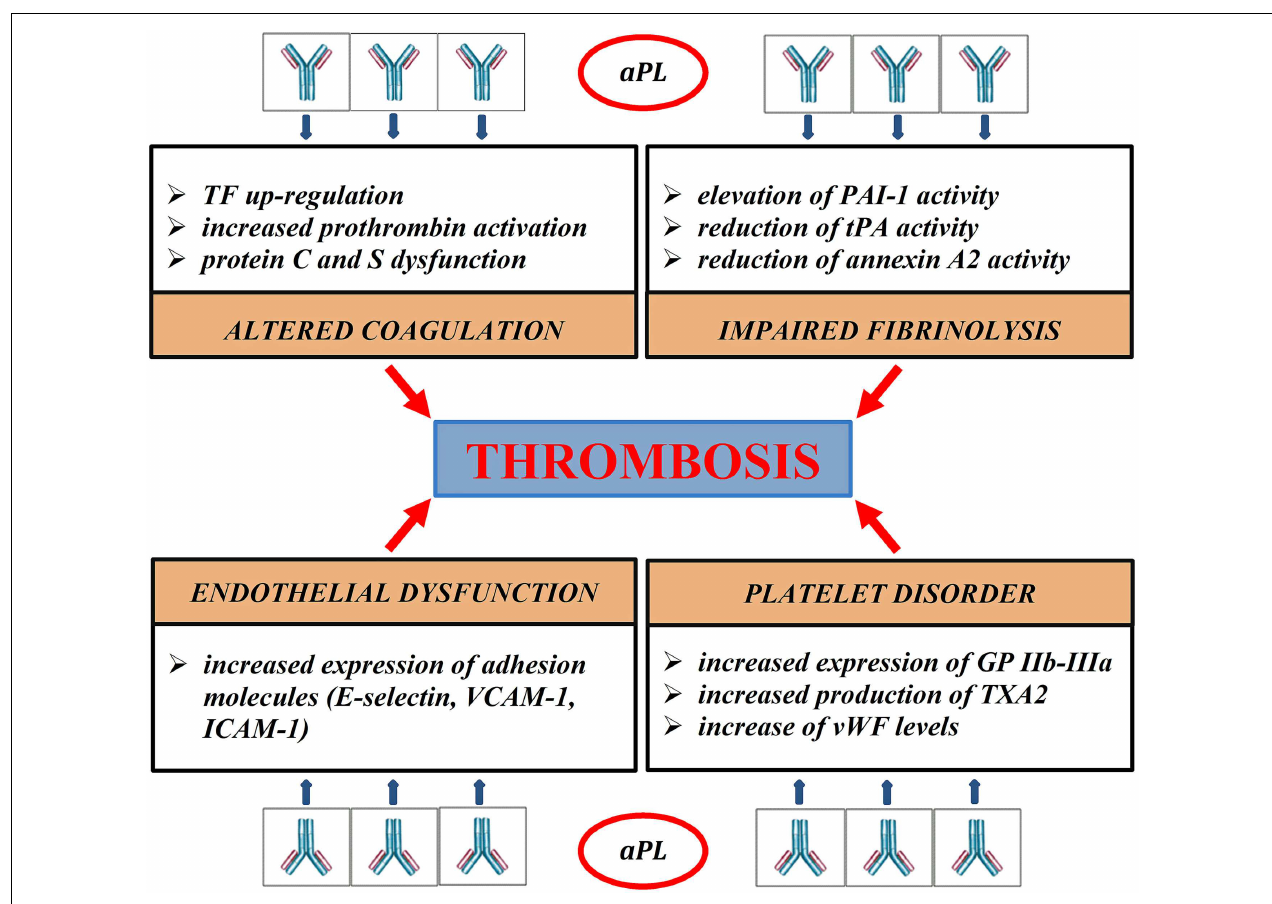
coagulation through up-regulation of tissue factor (TF) mRNA (Lambrianides et al., 2010). APL damage platelet aggregation process. They increase platelet expression of glycoprotein IIb-IIIa (GP IIb-IIIa) and synthesis of thromboxane A2 (TXA2; Robbins et al., 1998; Pierangeli et al., 2008); aPL can also reduce the inhibitory activity of β 2-GPI on von Willebrand factor (vWF), promoting platelet aggregation (Hulstein et al., 2007). In experimental models aPL generate a proinflammatory state, increasing the secretion of cytokines, such as IL1 and IL6, and promoting the expression of adhesion molecules, such as E-selectin, intracellular cell adhesion molecules 1 (ICAM1), and vascular adhesion molecules 1 (VCAM1; Pierangeli et al.,